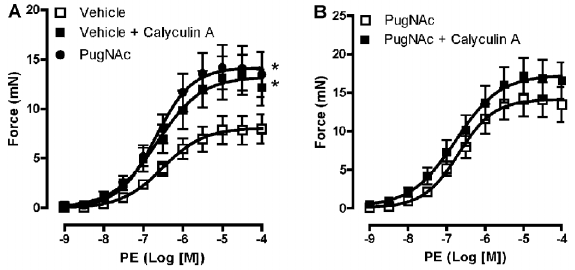
Figure 1. Calyculin A and PugNAc augment vascular reactivity to phenylephrine (PE). PugNAc and calyculin A produced similar increases in vascular contraction induced by PE in rat thoracic aorta ( A ) and co-incubation did not modify this response ( B ). Data are reported as means±SE (n=7). *P , 0.05 vs vehicle (10 m L/ mL methanol, vehicle to PugNAc, or 0.5 m L/mL DMSO, vehicle to calyculin A) (one-way ANOVA).